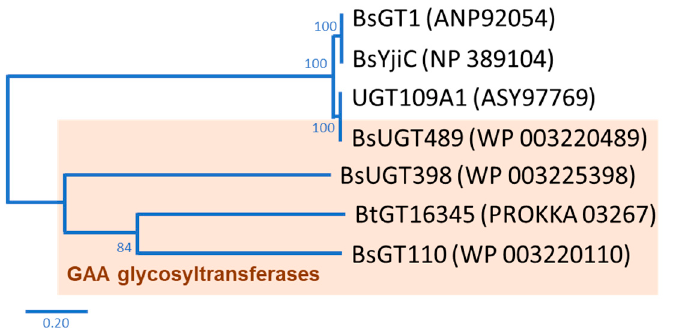
Figure 1. Seven known bacterial glycosyltransferases (GTs) from previous studies. The phylogenetic tree was adopted from Figure 1 in the study by Chang et al. [14]